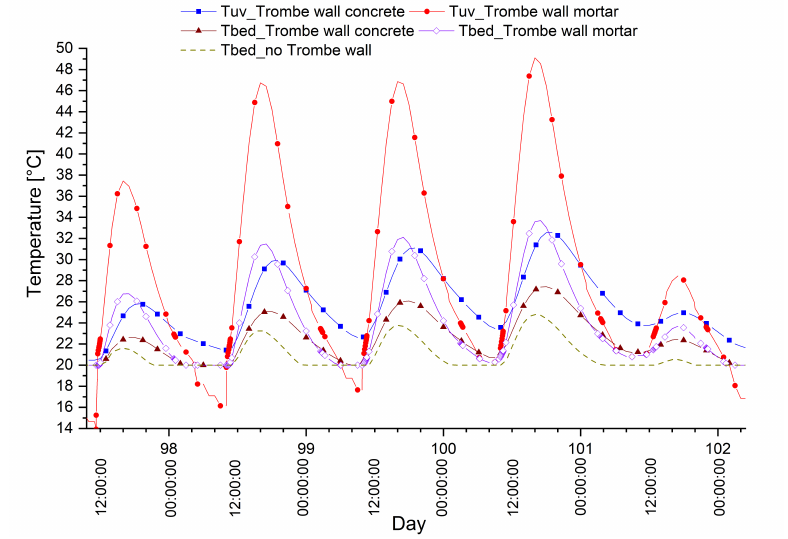
Figure 11. Temperatures inside the bedroom and air temperatures exiting the upper vent of the composite Trombe